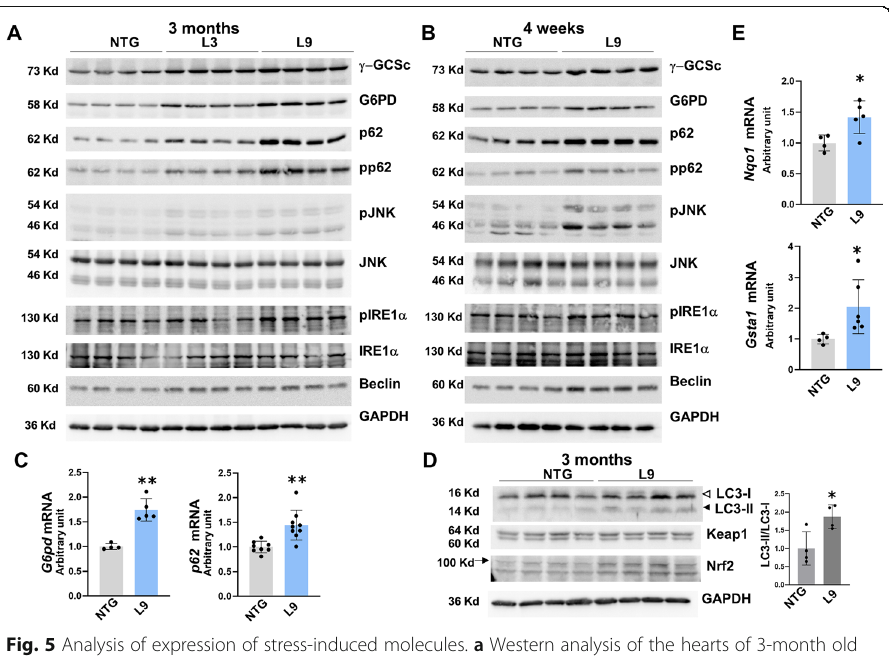
Fig. 5 Analysis of expression of stress-induced molecules. a Western analysis of the hearts of 3-month old male L3 and L9 mice. b Western analysis of the hearts of 4-week old male L9 mice. c Quantitative RT-PCR analysis of G6pd and p62 in the hearts of 3-month old male L9 mice. The results are presented as the means ± SD. Significance was assessed with unpaired t- test ( n = 4 ~ 9; ** p < 0.01 vs. NTG). d Western analysis of the hearts of 3-month-old male L9 mice. The white and black arrowheads respectively indicate LC3-I and LC3-II. An arrow indicates Nrf2. The right panels show relative densitometric analysis of the western blot of LC3. The results are presented as the means ± SD. Significance was assessed with unpaired t- test ( n = 4; * p < 0.05 vs. NTG). a , b and d : Whole cell extracts were examined with the indicated